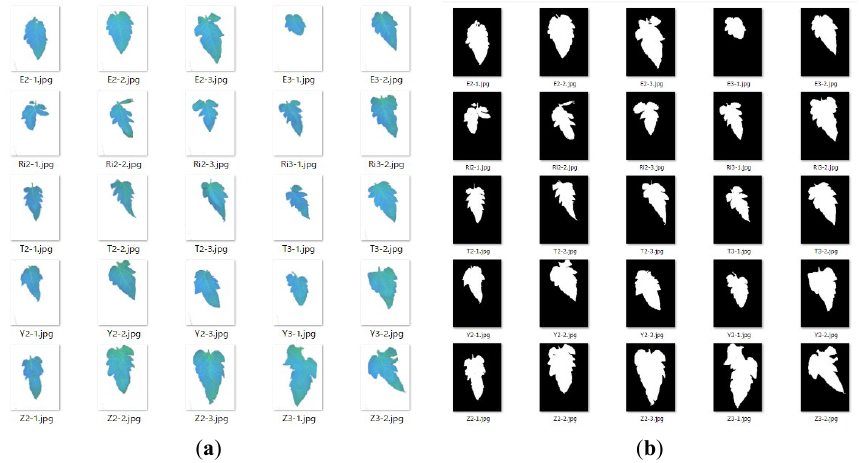
Figure 3. Hyperspectral image processing and data analysis. ( a ) Extraction of the leaf image (R: 1000 nm, G: 1430 nm, B: 1530 nm). ( b ) Leaf area calculation.